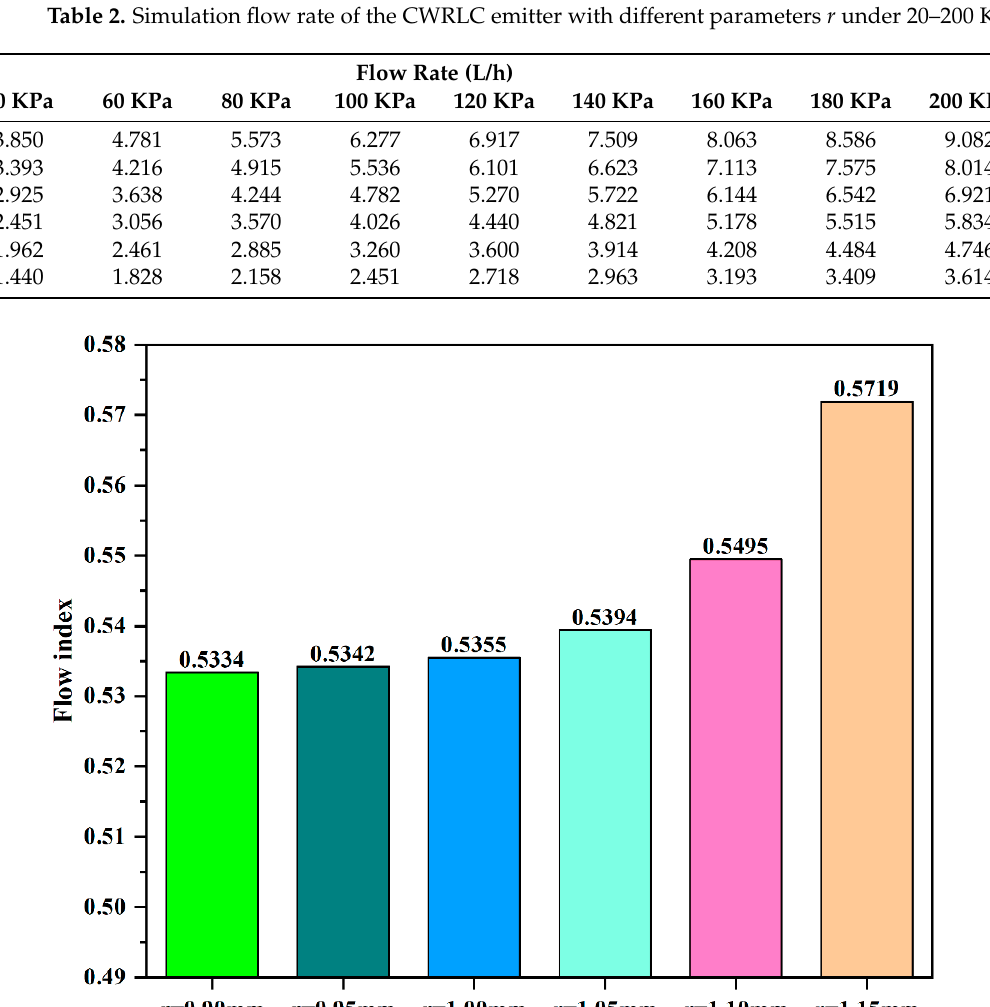
Table 2. Simulation flow rate of the CWRLC emitter with different parameters r under 20–200 KPa.